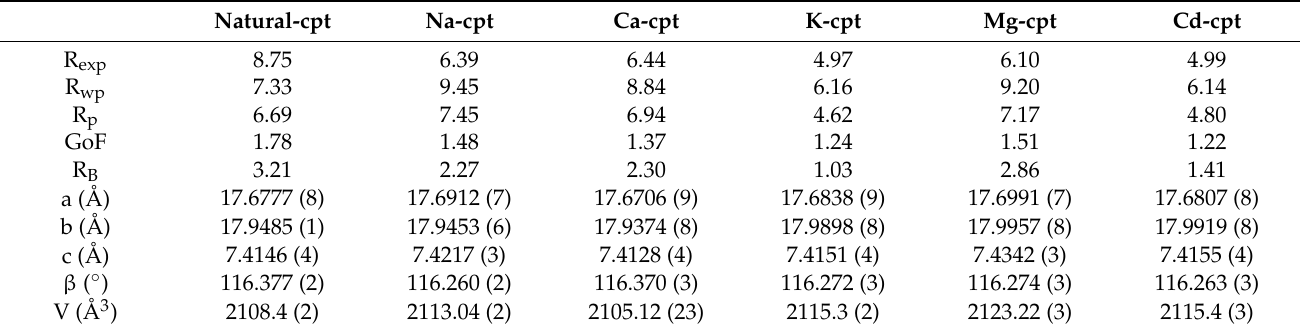
Table 4. Reliability factors and unit-cell parameters of Natural-cpt and exchanged clinoptilolite forms. Natural-cpt Na-cpt Ca-cpt K-cpt Mg-cpt Cd-cpt